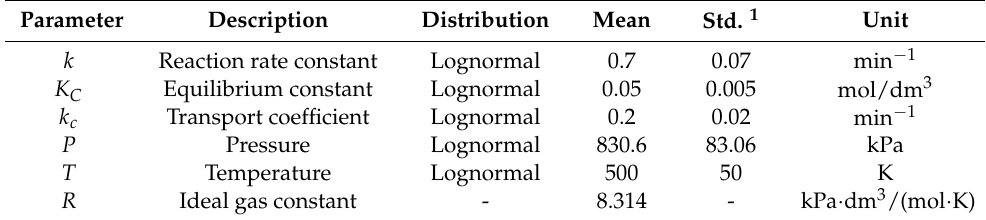
Table 5. Description of model parameters in Example 2